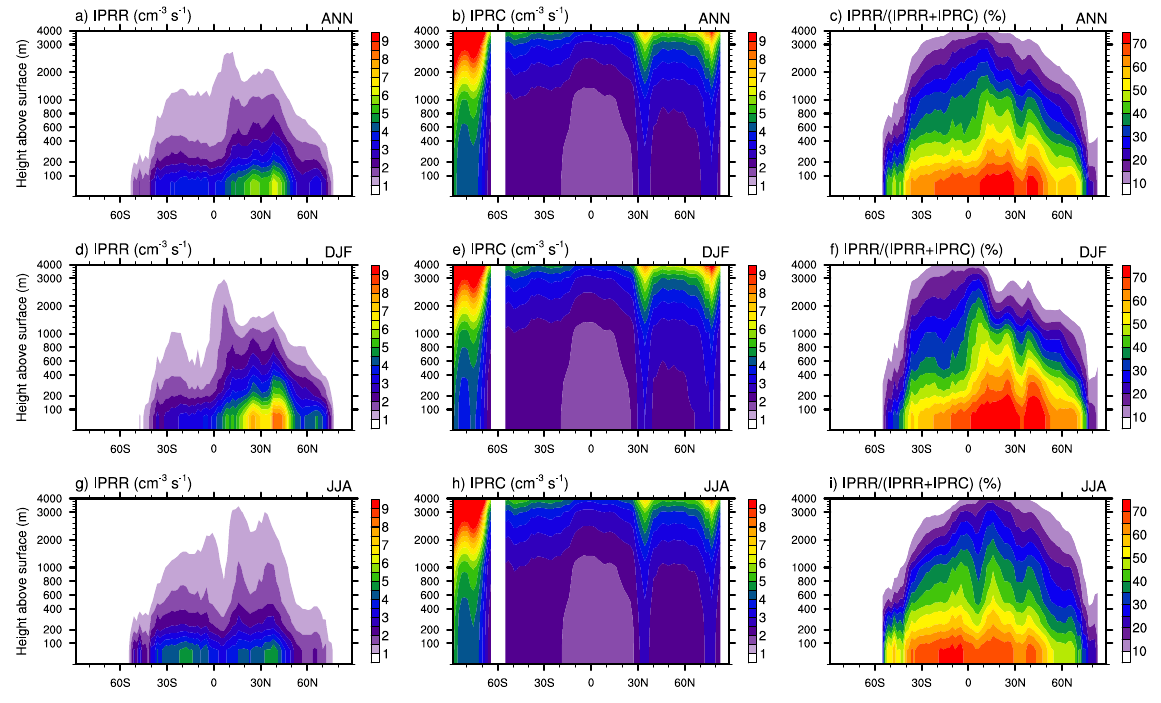
Fig. 12. Left column: simulated zonal mean ionization rate over the continents caused by the radioactive decay of radon and its progeny (IPRR, unit: cm − 3 s − 1 ); Middle column: as in the left column but caused by galactic cosmic rays (IPRC, unit: cm − 3 s − 1 ); Right column: the contribution of radon and its progeny to the total (IPRR + IPRC) ionization rate. All panels correspond to the simulation performed with the merged emission map.